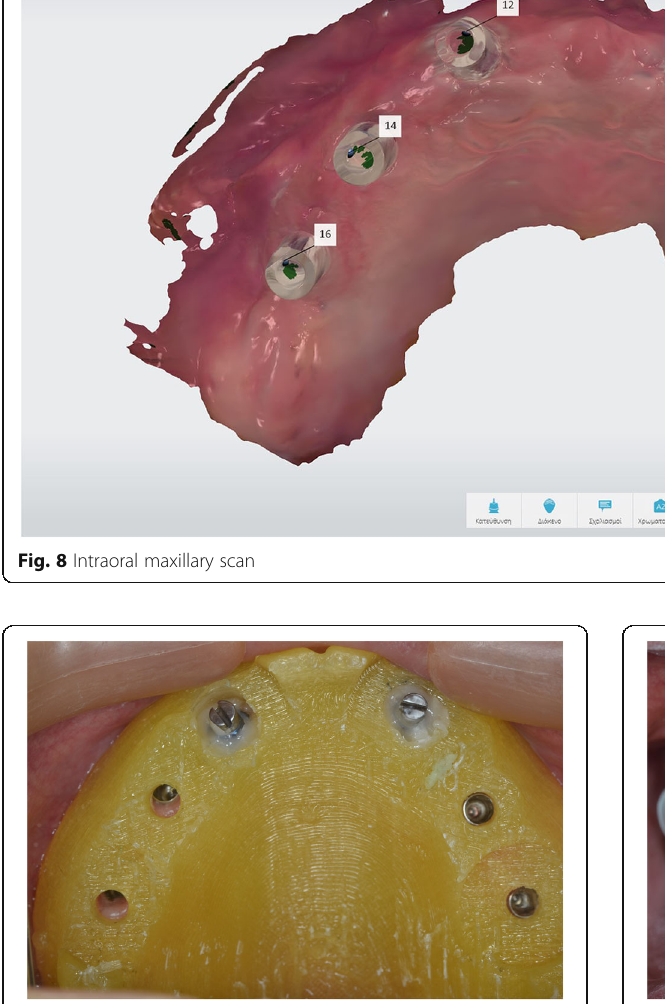
Fig. 9 Surgical guide secured onto mesial implants with modified implant carriers showing preserved central incisors and first molars